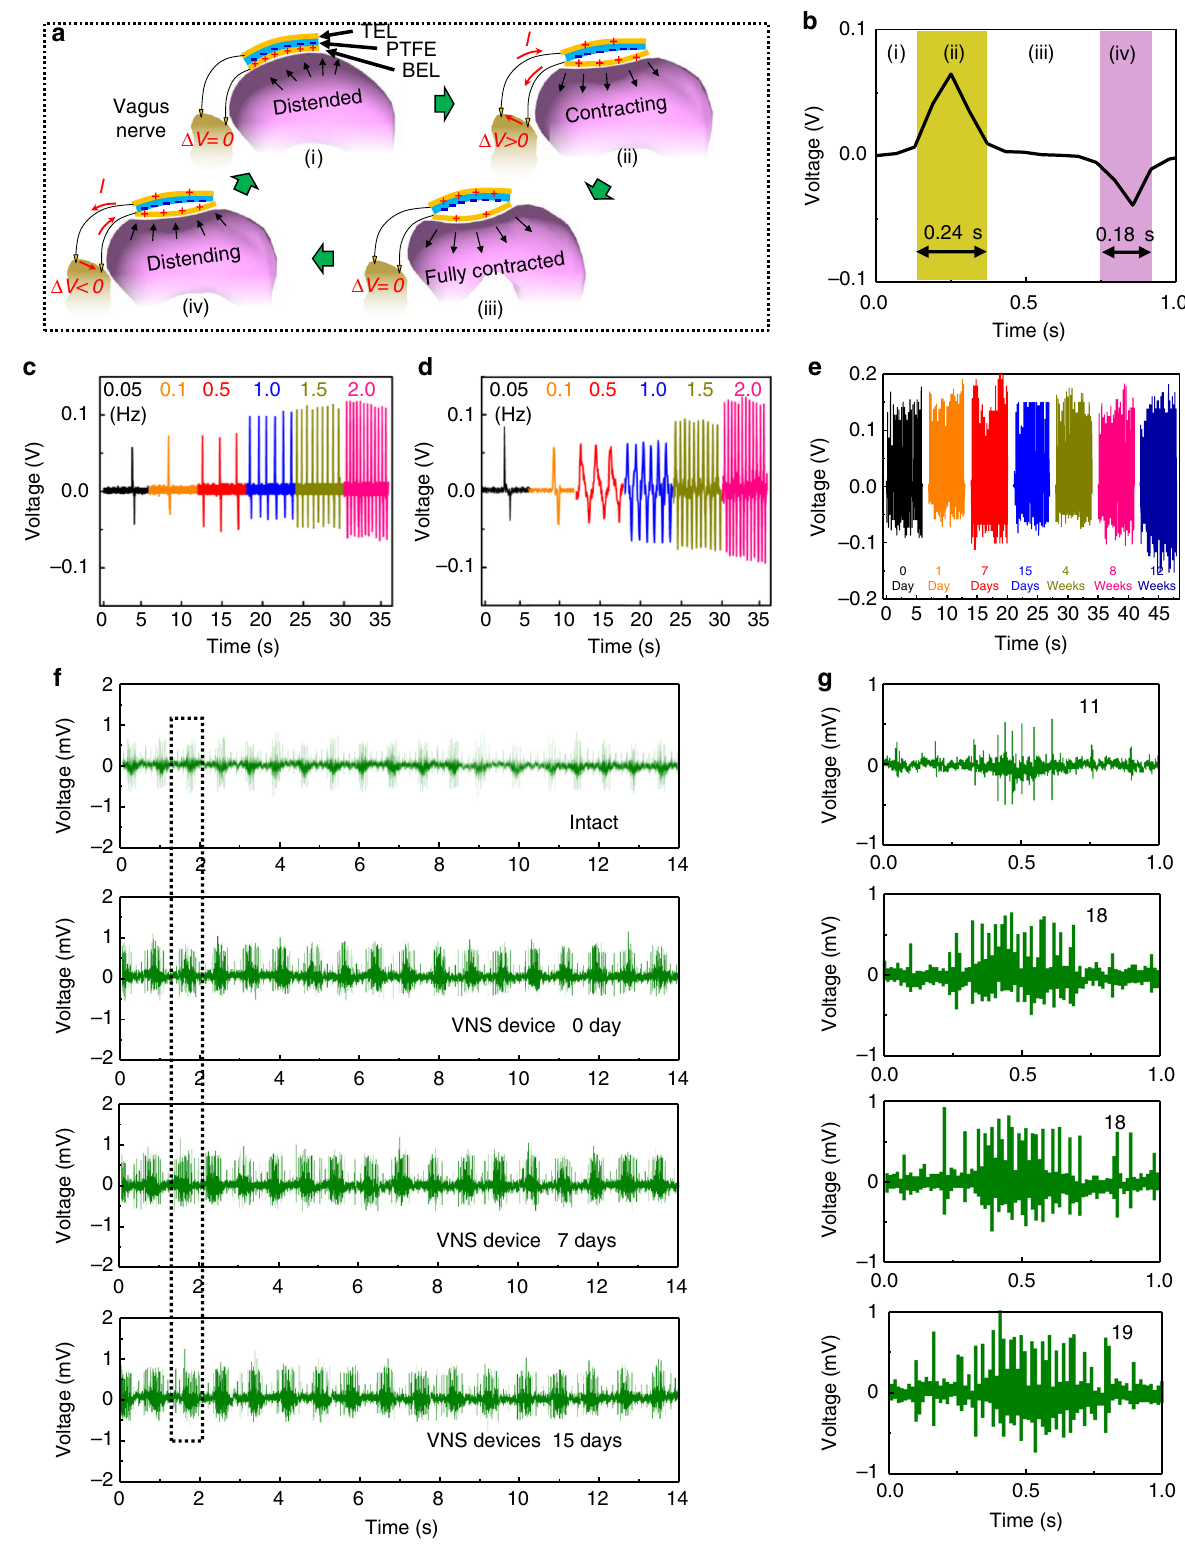
Fig. 2 Working principle and voltage signal of the vagus nerve stimulation device. a Schematics of the working principle of VNS device under different stomach motion stages. b A typical single-cycle voltage biphasic signal corresponding to the four stages of stomach movement at a frequency of 0.05 Hz. c Voltage signal measured in PBS solution under different agitation frequency when the VNS device was connected to an external load with the same impedance of the implanted area. d Voltage signal measured when the VNS device was implanted and connected to vagus nerves. e Long-term stability test of the VNS device, where the device was removed from the rats and the voltage was measured on an external load of 0.3M Ω . f Electrophysiological signals recorded from rats without implantation and with an active implanted VNS device on the same day, and 7 and 15 days post implantation. g Enlarged view of one group of electrophysiological signal highlighted in the dotted box in